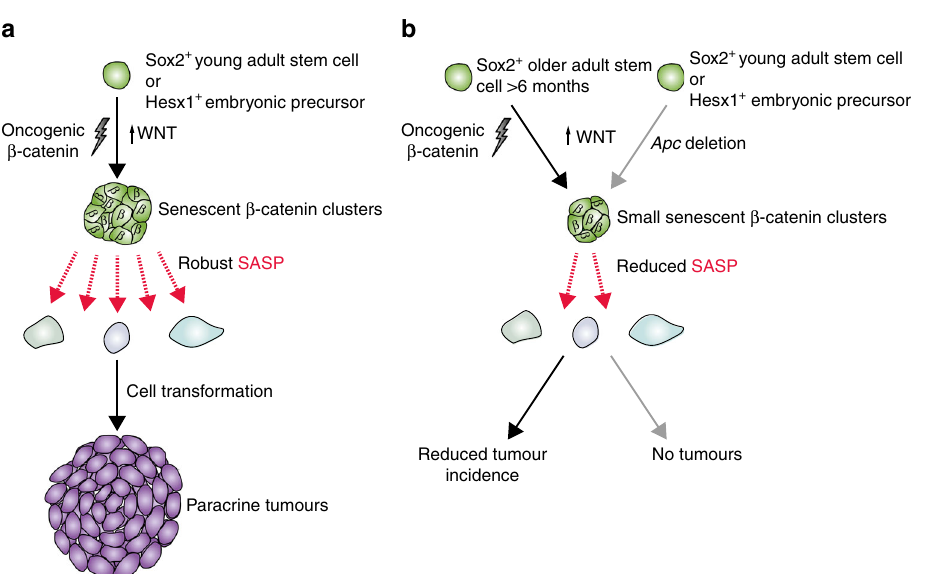
Fig. 8 Schematic summary of the main fi ndings of this research. a Targeting Sox2+ stem cells from young adults, or Hesx1+ embryonic precursors to express oncogenic β -catenin, results in formation of senescent cell clusters and a robust SASP. This leads to cell transformation and generation of the cell- of-origin of the paracrine tumours, thus the tumours are not derived from the mutation-sustaining cells. b In contrast, the expression of oncogenic β - catenin in Sox2+ stem cells of older mice leads to a reduced tumour incidence or the failure to produce tumours. In addition, upregulation of the WNT pathway through the deletion of Apc in young adult stem cells or embryonic precursors also fails to induce tumours. In all cases described in b , there is attenuated senescence and SASP